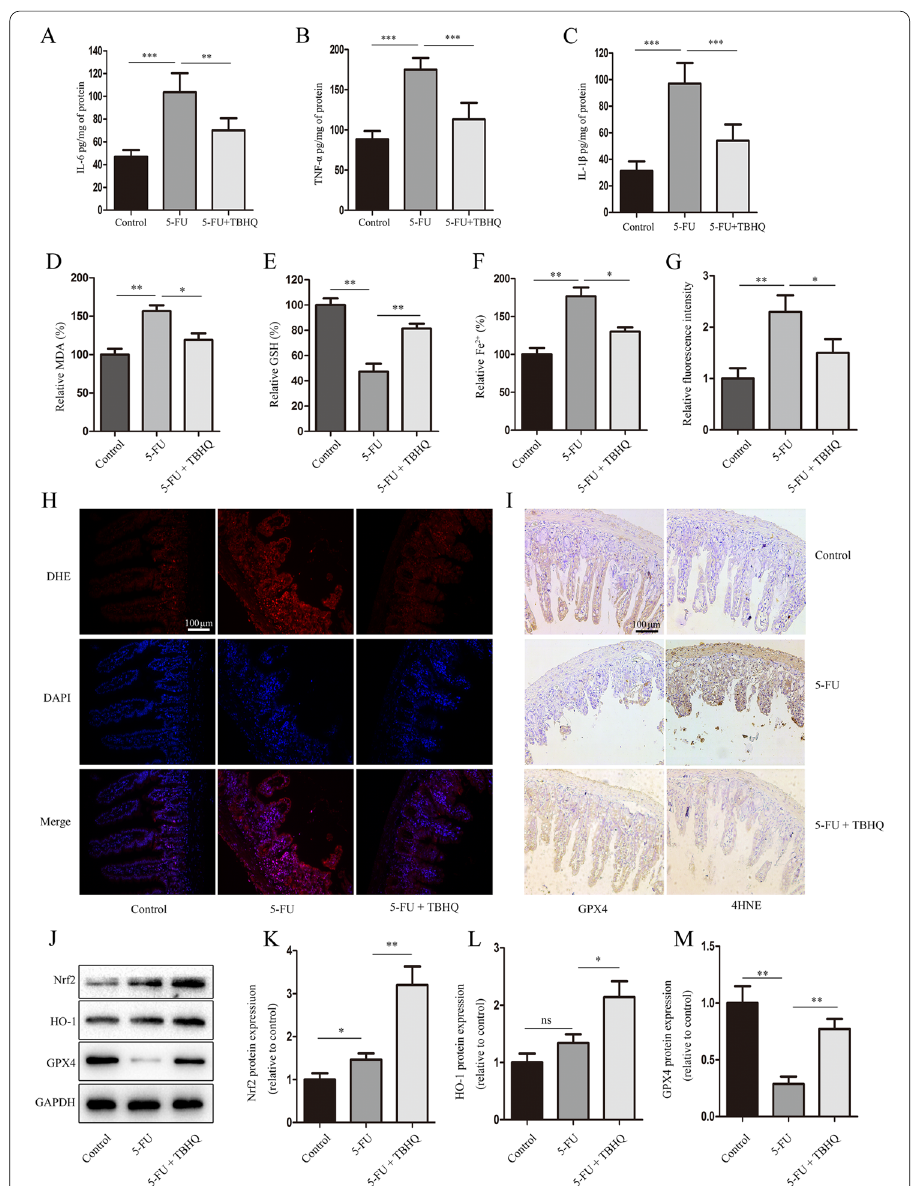
Fig. 3 TBHQ inhibits 5-FU-induced intestinal epithelial cell ferroptosis via the Nrf2/HO-1 pathway. A through C – The expressions of IL-6, TNF-α, and IL-1β. D through F –The relative levels of malondialdehyde (MDA), glutathione (GSH), and Fe 2 + . G and H The levels of reactive oxygen species (ROS) were assessed using DHE staining. I – The expressions of 4HNE and GPX4 (scale bars: 100 μm). J through M – The expressions of Nrf2, HO-1, and GPX4 in the small intestine tissues were determined using western blotting. *p < 0.05, **p <